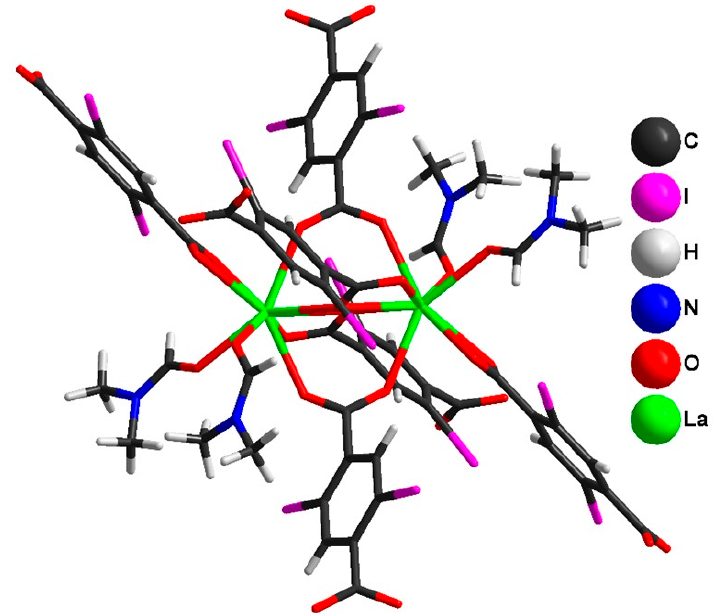
Figure 5. Structure of [La 2 (2,5-I-bdc) 6 (DMF) 4 ] in the crystal structure of 2 .